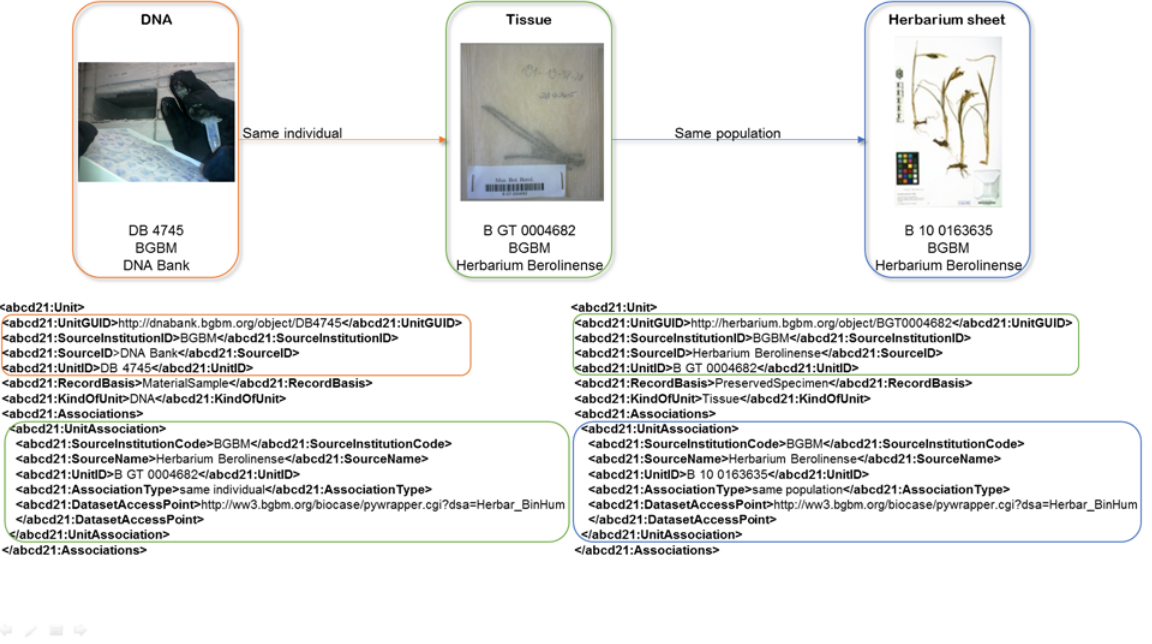
Fig 3. Representation of associated units in ABCD 2.1. A DNA Sample with the triple ID “ DB 4745 — BGBM — DNA Bank ” is associated to a tissue (triple ID “ B GT 0004682 — BGBM — Herbarium Berolinense ” ). This tissue is associated to a herbarium sheet (triple ID “ B 10 0163635 — BGBM — Herbarium Berolinense ” ). The associated dataset access point and triple ID make it possible to retrieve each record.